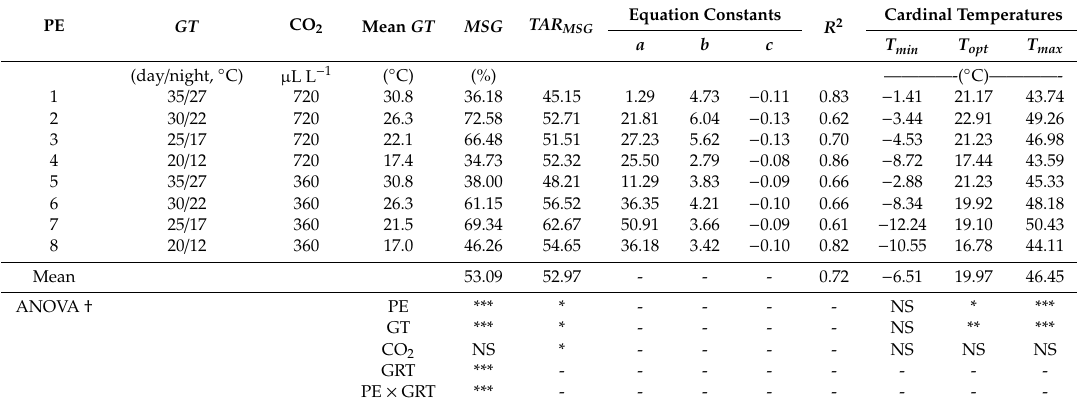
Figure 2. Germination time courses of eight parental environments when averaged across a range of germination temperatures (10–42.5 °C). Lines fitted through a three-parameter sigmoidal curve represent germination time course, and symbols represent germination data. Data are means ± standard error (SE) of four plants ( n = 4) harvested from a given SPAR unit and used as replicates in statistical analysis for a respective parental environment.